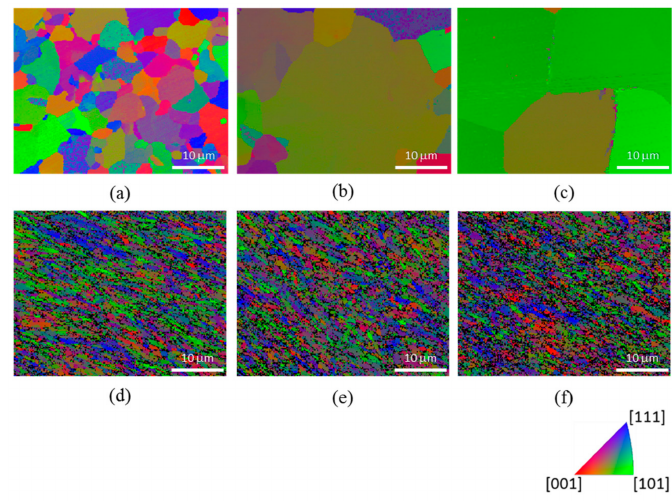
Figure 1. Electron backscatter diffraction (EBSD) images acquired from coarse-grained (CG) alloys with ( a ) 8%, ( b ) 10% and ( c ) 12% Cr and ultrafine grained (UFG) alloys prepared by equal-channel angular pressing (ECAP) with ( d ) 8%, ( e ) 10% and ( f ) 12% Cr.